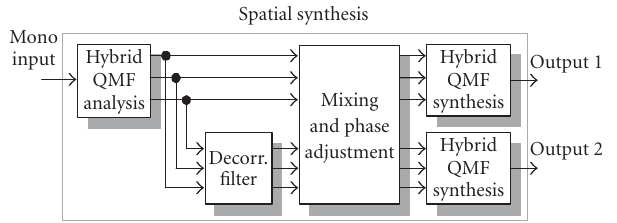
Figure 6: Structure of the QMF-based decoder. The signal is first fed through a hybrid QMF analysis filter bank. The filter-bank out- put and a decorrelated version of each filter-bank signal are sub- sequently fed into the mixing and phase-adjustment stage. Finally, two hybrid QMF banks generate the two output signals.